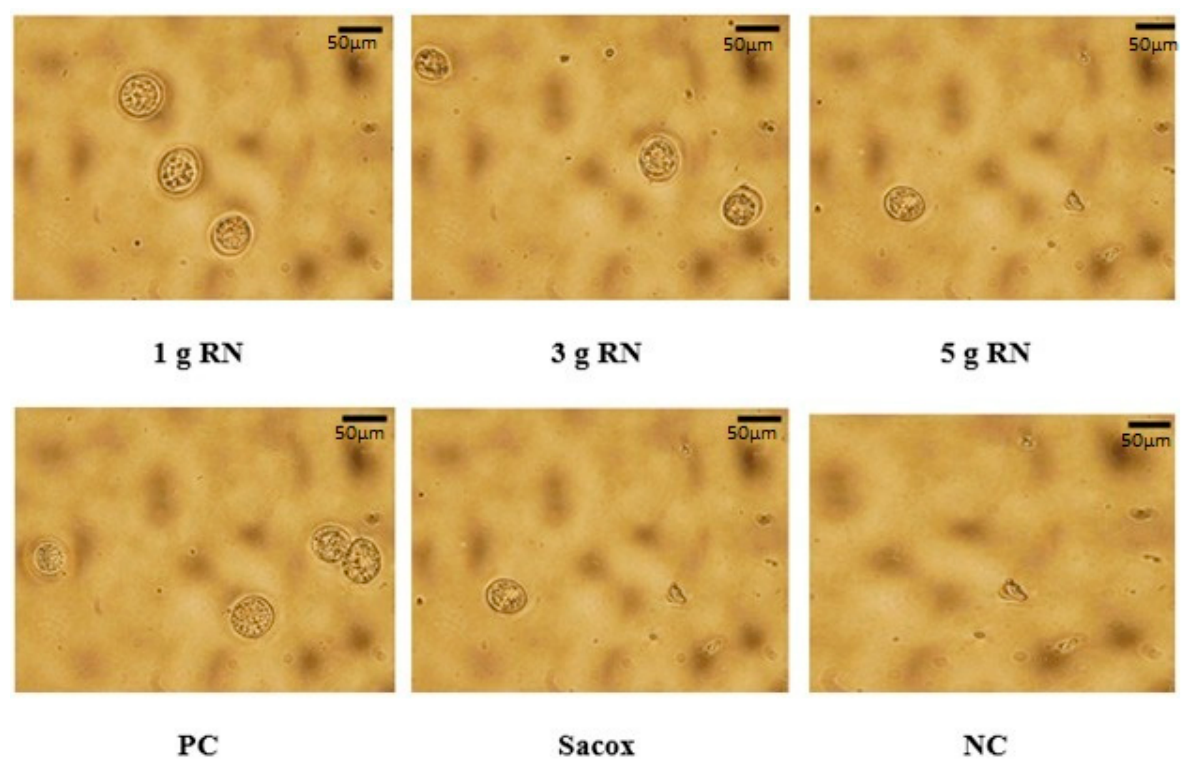
Figure 3. Oocyst morphology of E. tenella in the infected experimental treatments. R1g, R3g, and R5g are 1, 3, and 5 g RN/kg diet, respectively, Sacox: 66 mg of salinomycin/kg diet, PC and NC: basal diet with and without coccidiosis challenge, respectively. Magnification under object lens 40× and scale bar 50 µm.